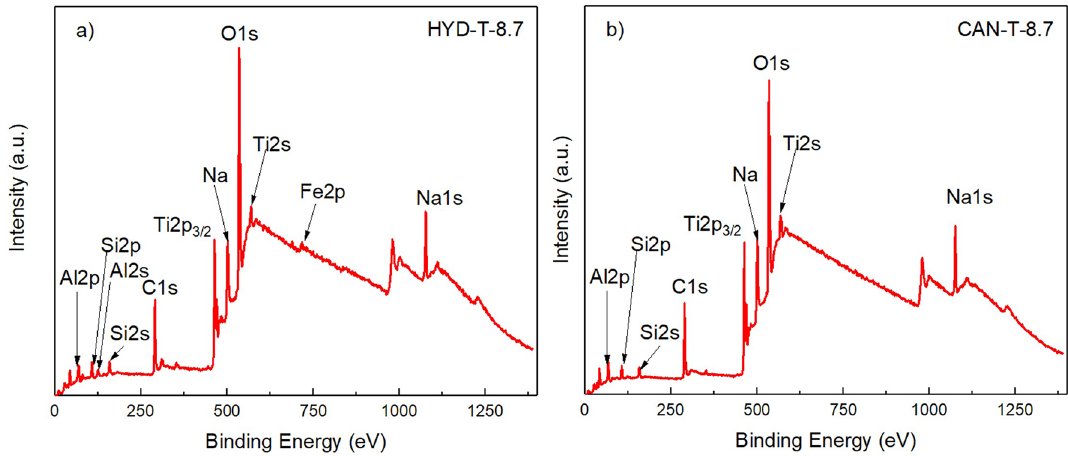
Figure 1. Wide XPS spectra of the samples ( a ) HYD-T-8.7 and ( b )